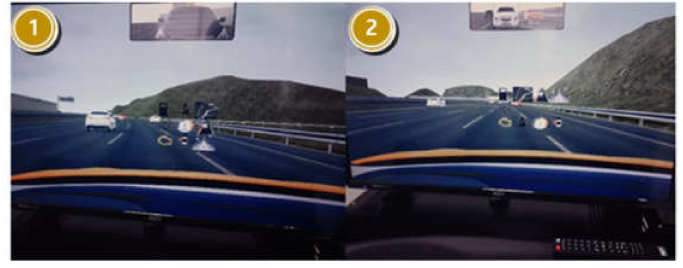
Figure 5. Classification for arrangement of